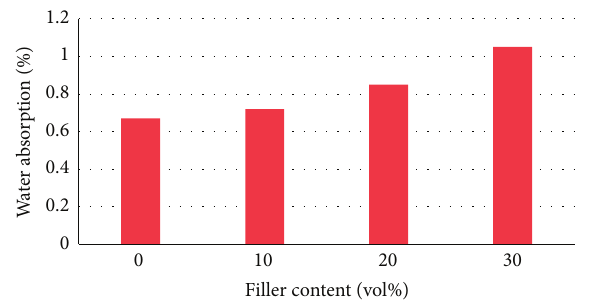
Figure 2: Water absorption of UPE/OPS